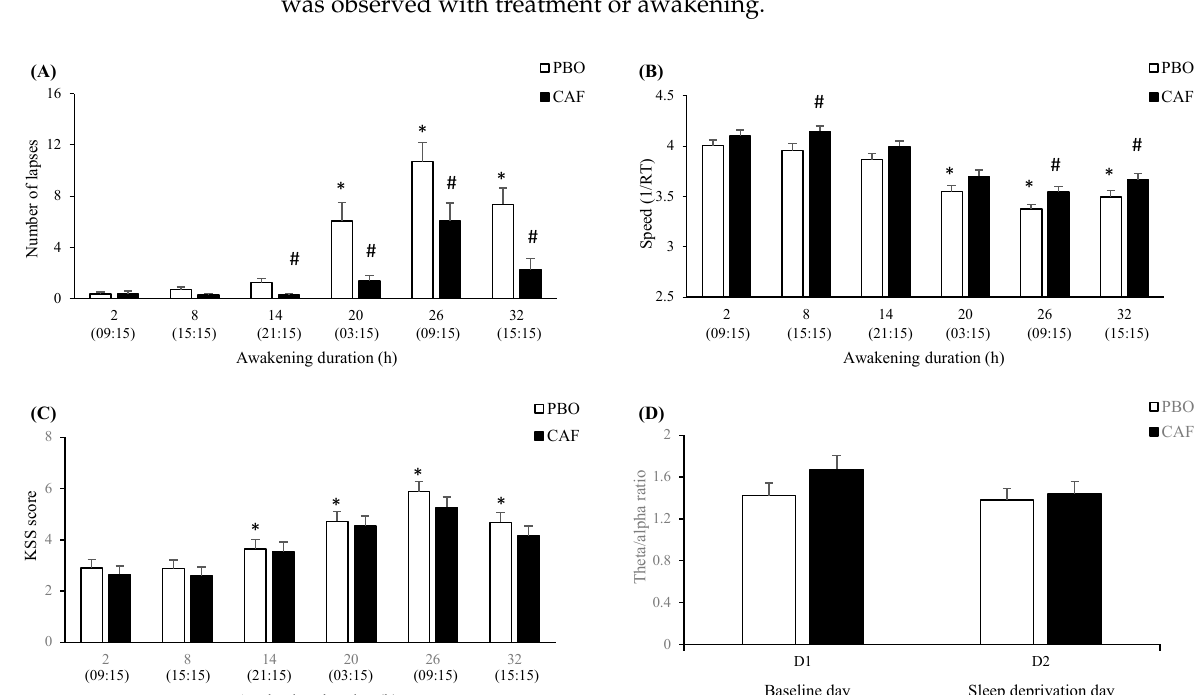
Figure 2. Mean PVT performance over 38-h of prolonged wakefulness for a number of lapses ( A ), speed ( B ), KSS score ( C ), and the EEG theta-to-alpha ratio ( D ) during PVT in the centrotemporal brain region at 09:15 on D1 (baseline) and D2 (sleep deprivation) days as a function of placebo (PBO) or caffeine (CAF) condition. Values are mean ± SEM. * difference between baseline and continuous wakefulness, # between PBO and CAF conditions.